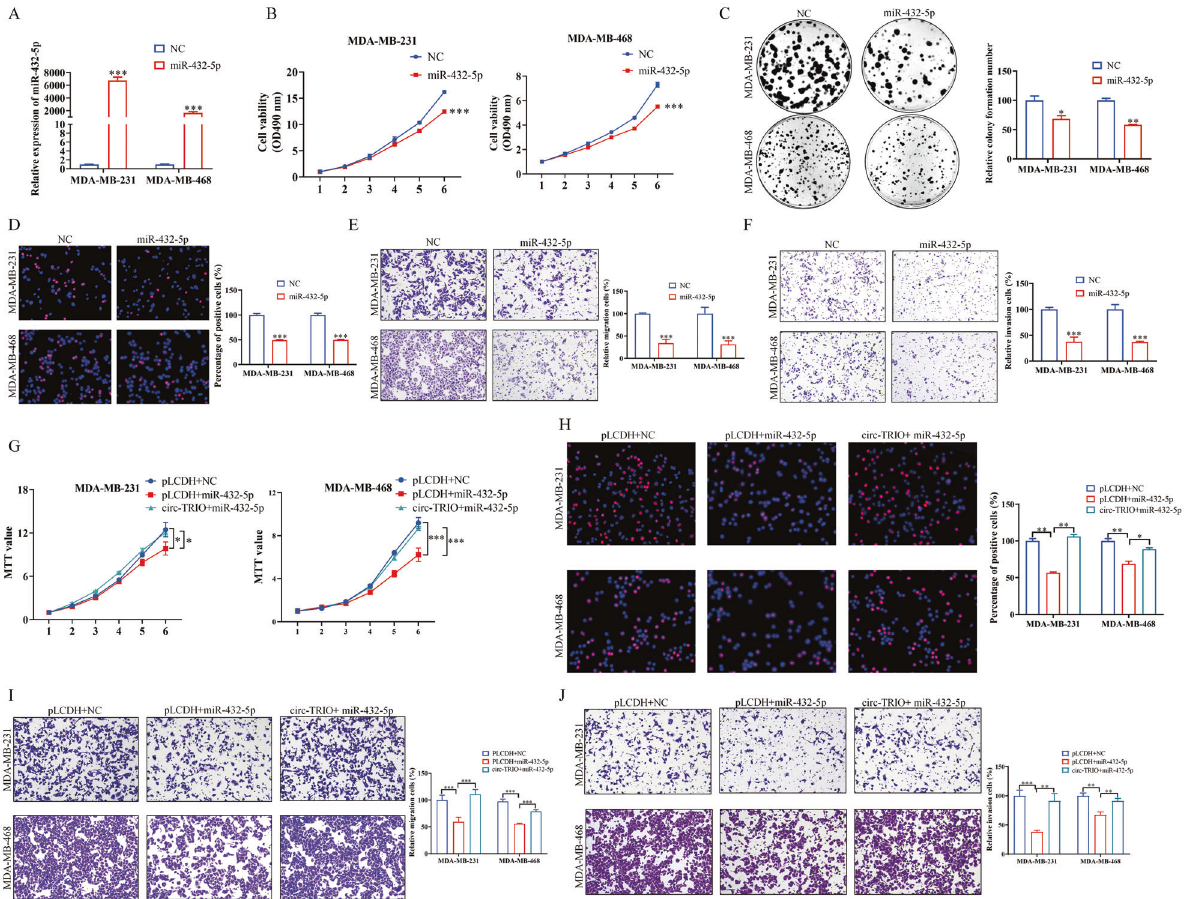
Fig. 5 Overexpression of miR-432-5p inhibits breast cancer progression and reverses the oncogenic effects of circ-TRIO in TNBC. A The ef fi ciency of miR-432-5p overexpression in TNBC cells. MTT ( B ), colony formation ( C ), and EdU ( D ) assays veri fi ed the effects of miR-432-5p overexpression on the TNBC proliferation rate. The migration ( E ) and invasion ( F ) abilities of MDA-MB-231 and MDA-MB-468 cell lines transfected with miR-432-5p mimics were evaluated using Transwell assays. MTT ( G ), EdU ( H ), and Transwell ( I, J ) assays revealed that the overexpression of circ-TRIO could reverse the effects of miR-432-5p. * p < 0.05; ** p < 0.01; *** p <